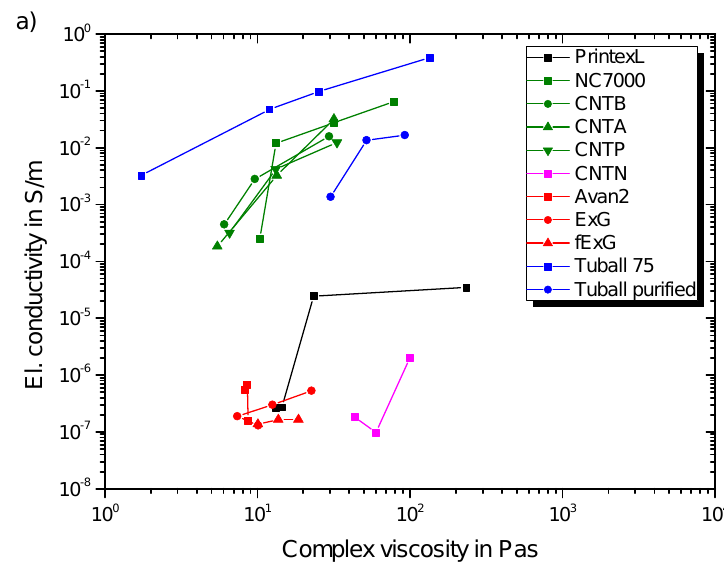
Figure 18. Summary of the electrical conductivity (cured state) in correspondence to the complex viscosity for all evaluated particle types in Epikote 828LVEL/RIMH 137/134 (liquid state). Figure 19 gives K IIC and the corresponding K IC values for the composites. Only Tuball 75 at 0.01 wt.% filler loading and CNTA up to 0.3 wt.% increase both fracture toughness values. CNTN